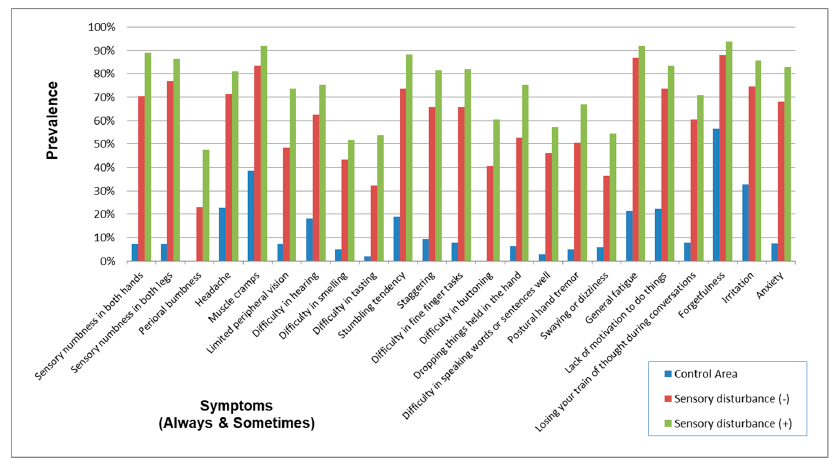
Figure 15. Prevalence of symptoms (Always) in subjects with and without sensory disturbance. The prevalence of symptoms was a little lower in subjects without sensory disturbance than in subjects with sensory disturbance but was apparently higher than the Control Area. The prevalence patterns were similar in exposed subjects with and without sensory disturbance.